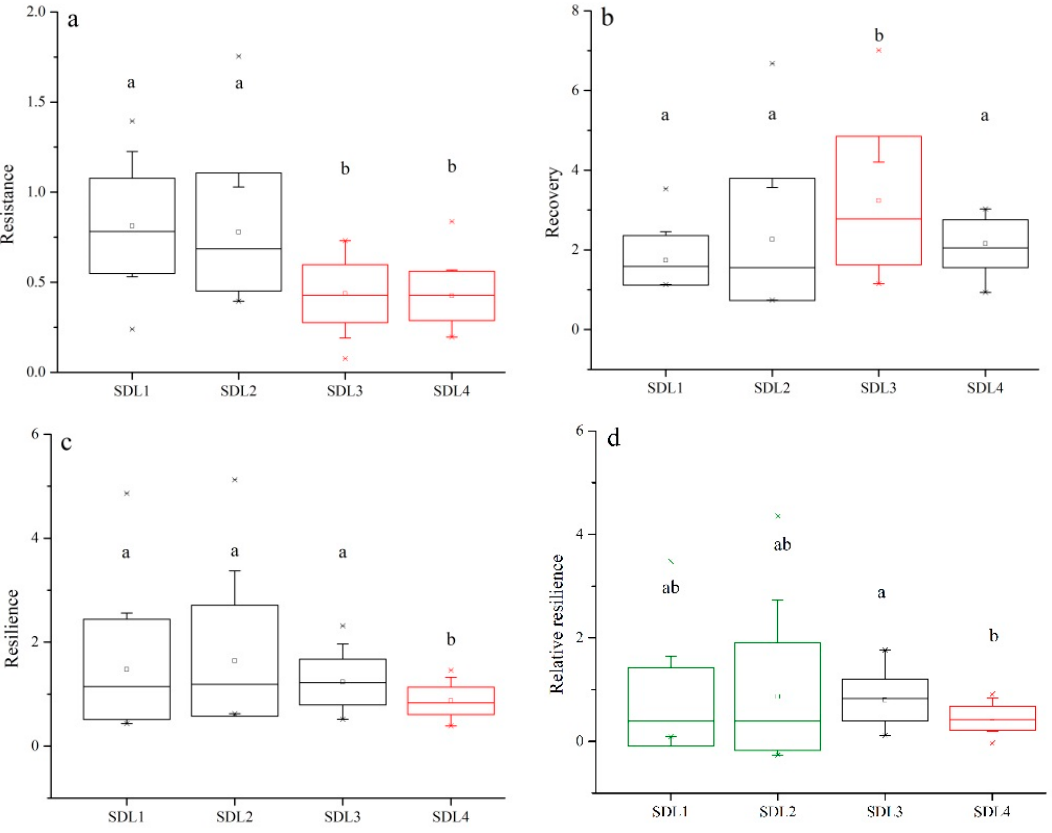
Figure 8. The altitudinal di ff erences in stable indices (( a ): Resistance; ( b ): Recovery; ( c ): Resilience, ( d ): Relative resilience) for the early drought event indicated by ANOVA analysis. The di ff erent letters above the boxes indicate significant di ff erences between the two boxes, the same letter indicates an insignificant di ff erence. SDL1, SDL2, SDL3, and SDL4 refer to the di ff erent sampling sites shown in Table